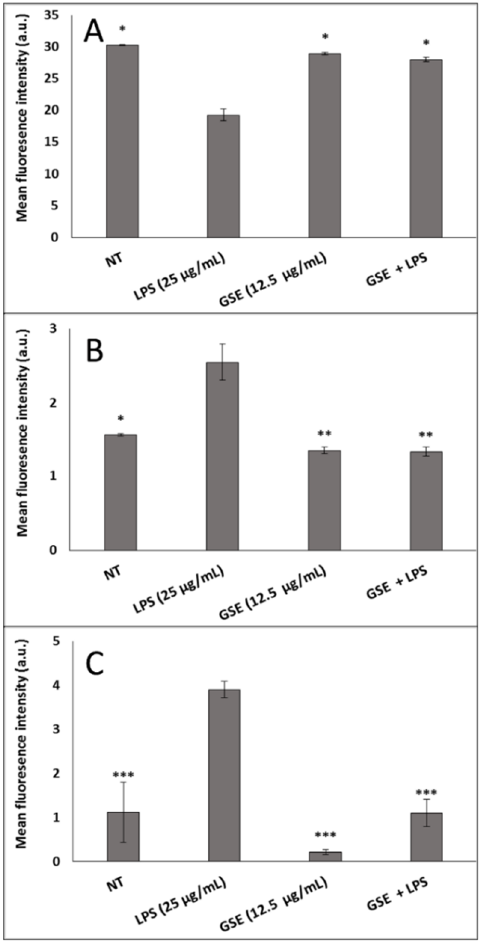
Figure 2. Effect of Grape Seed Extract (GSE) on mitochondrial damage in Caco-2 cells induced by Lipopolysaccharide (LPS). ( A ) After the cells were treated with LPS, GSE, and LPS + GSE for 24 h, mitochondrial membrane potential was measured revealing decreased membrane potential in LPS-treated cells compared to control while GSE treatment restored membrane potential. ( B ) Intracellular reactive oxygen species (ROS) were significantly increased in LPS-treated cells compared to control and control levels were restored by treatment with GSE as measured by 2′,7′-dichlorofluorescein (DCFH2-DA) fluorescence. ( C ) Mitochondrial superoxide was assessed with mitosox red dye revealing an increase in mitochondrial ROS in LPS-treated cells which was reduced by treatment with GSE. Error bars indicate ± S.D. ( n = 3). *, **, and *** indicate the data were significantly different relative to LPS-treated cells with p ≤ 0.05, p ≤ 0.01, and p ≤ 0.001 respectively using Tukey’s test. NT, Non-Treated.